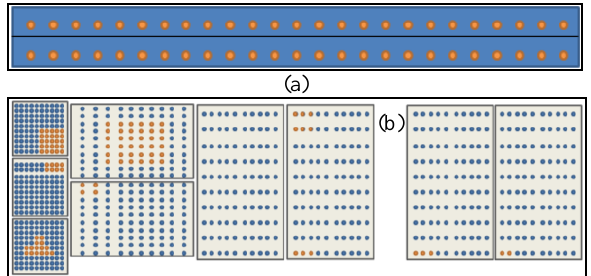
Figure 5: Rough diagram of observer and target points: (a) Observer points along left and right lane of road; and (b) Target points per billboard (blue and orange); Target points of logos